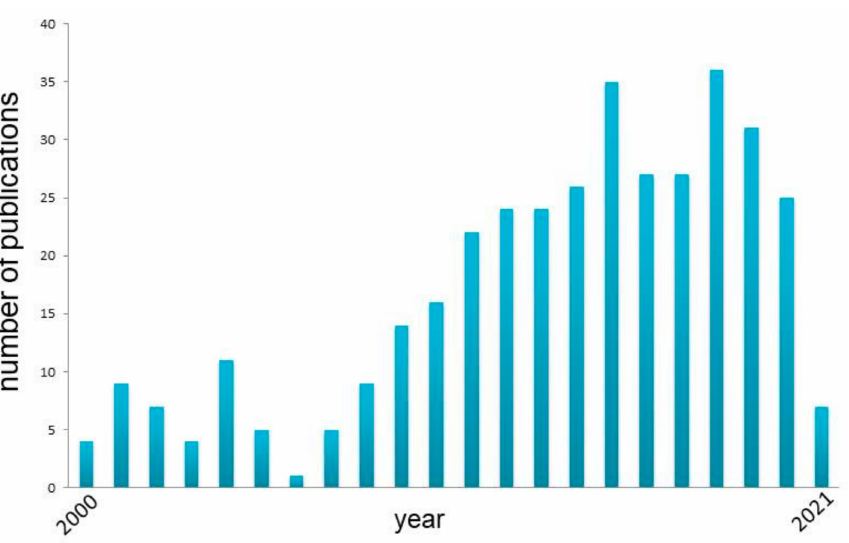
Figure 3. Increase in number of publications with phrase “human single-neuron recordings”. Data from